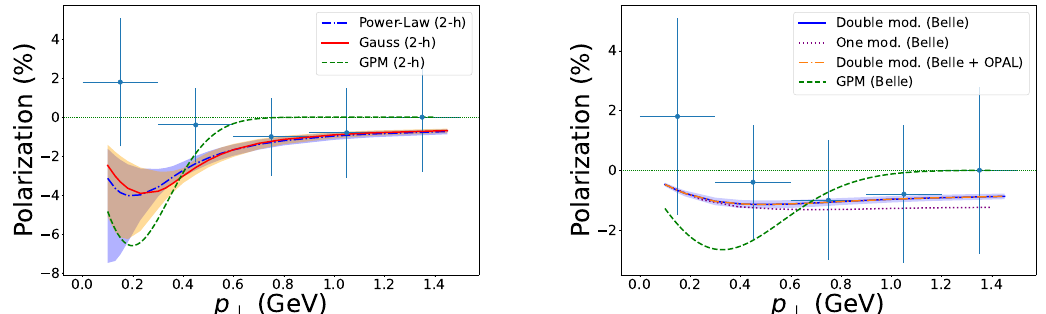
Figure 13 . Predictions for the transverse Λ polarization in e + e − → Λ X as a function of p ⊥ at √ s = M Z , integrated over z h in the range [0 . 15 , 1] , against OPAL data [29]. Left panel, 2-h fit: Power-Law (blu dot-dashed line), Gaussian (red solid line) model and GPM results [32] (dashed green line) from double-hadron fits. Right panel, combined fits within the Power-Law parametrization: double-model fit (blue solid line), one-model fit (violet dotted line) and global analysis (Belle + OPAL data) within the double-model fit (orange dot-dashed line). We also show the results within the GPM approach [32] (green dashed line). For some cases uncertainty bands are